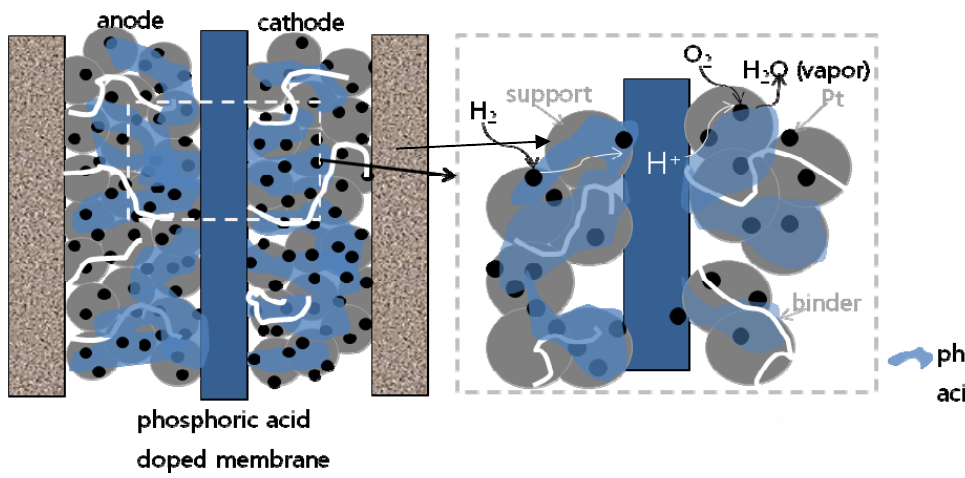
Figure 10. Cross-section scheme of the high-temperature PEMFC